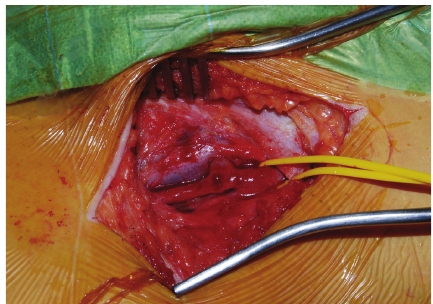
Figure 2: An intraoperative photo demonstrating the AV fistula between SFA and